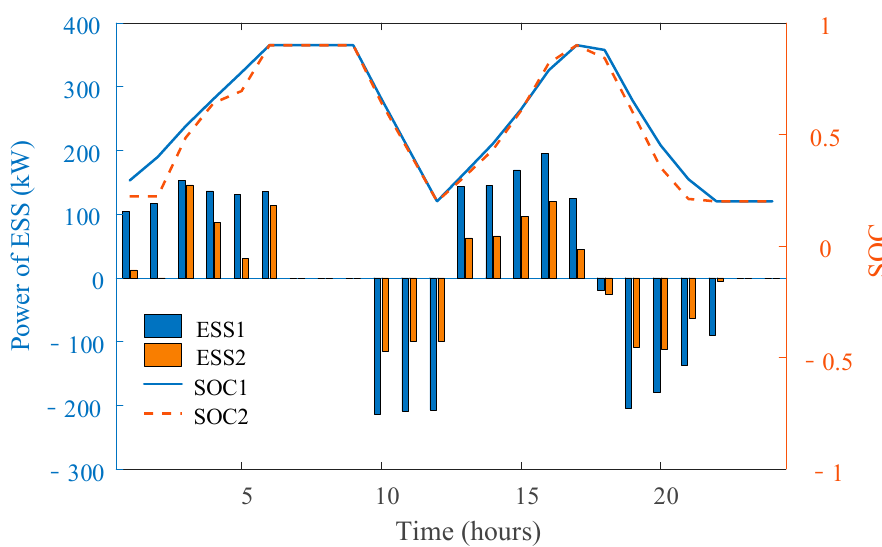
Figure 5. The optimized dispatch results of ESSs for 33-bus distribution network.